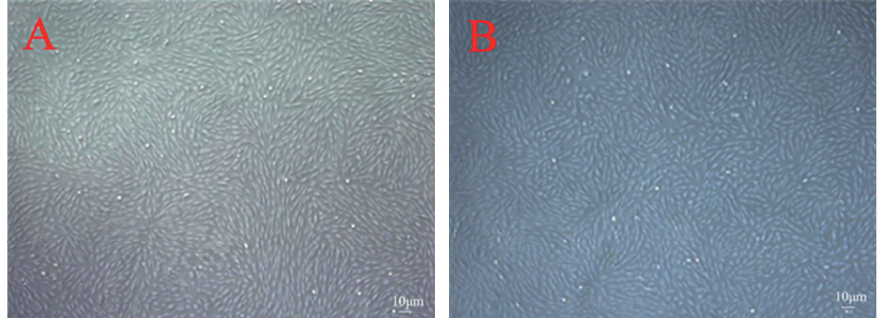
Figure 1: Subcultured cynomolgus monkey ciliary muscle (CM) cells and cynomolgus trabecular meshwork (TM) cells ( × 40). (a) The cultured CM cells were spindle-shaped and merged into a single layer to form a hill-and-valley pattern typical of human ciliary muscle cell in vitro. (b) The cultured TM cells are diverse in morphology between the epithelial cell type and the fibroblast type.